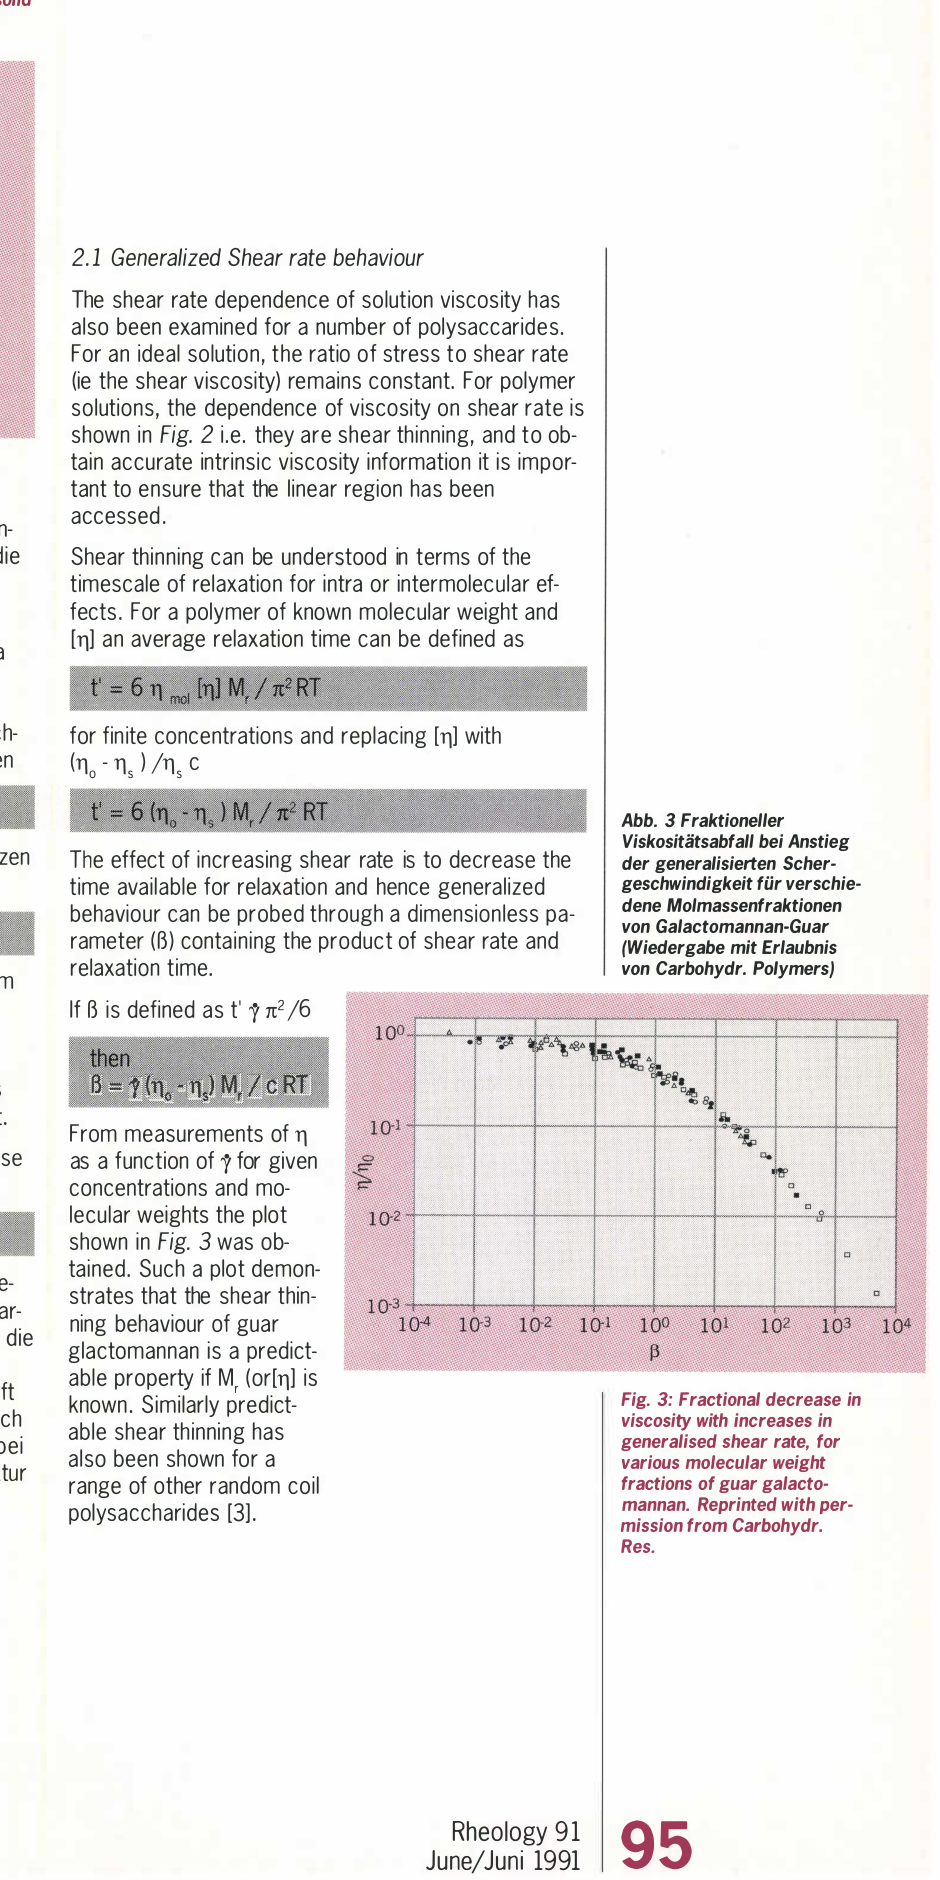
Fig. 2: Shear rate (g) dependence of viscosity for a Newtonian liquid (dashed line) and a typical polysaccharide solution (solid line). Reprinted with permission from Carbohydr. Polymers